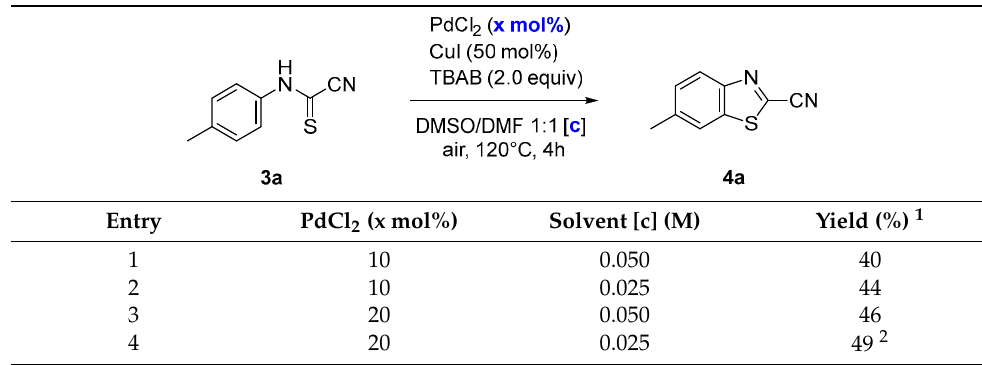
Table 1. Preliminary exploration of reaction conditions.